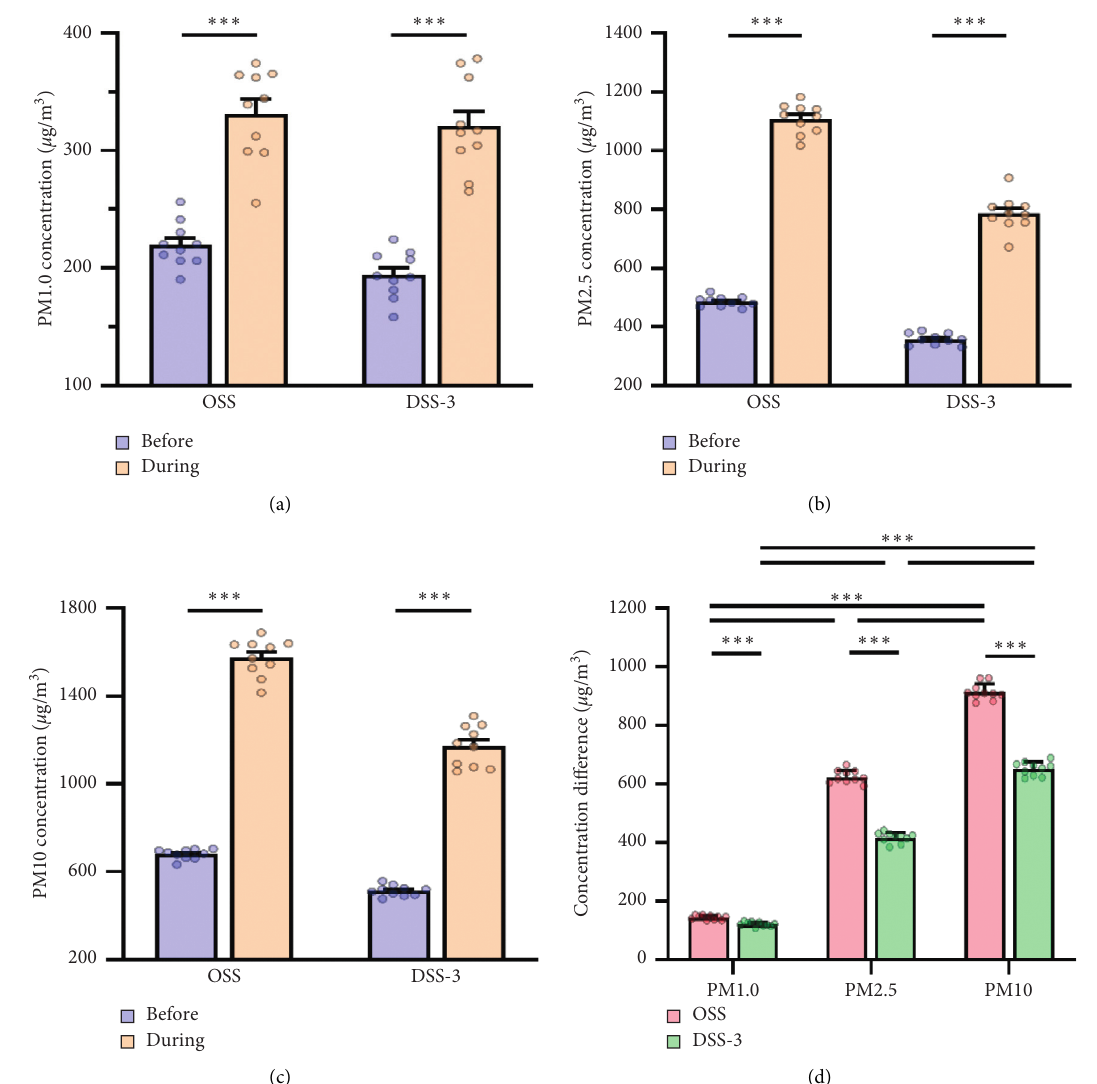
Figure 8: Comparison of dust particles before and during shotcrete construction with two mix proportions. (a) PM1.0 concentration; (b) PM2.5 concentration; (c) PM10 concentration; (d) concentration difference of dust particles before and during shotcrete construction. Data are mean ± s.e.m. of the indicated number of independent experiments. ∗ P < 0.05, ∗∗ P < 0.01, and ∗∗∗ P < 0.001. One-way ANOVA de- termined P values with Tukey’s multiple comparison post hoc